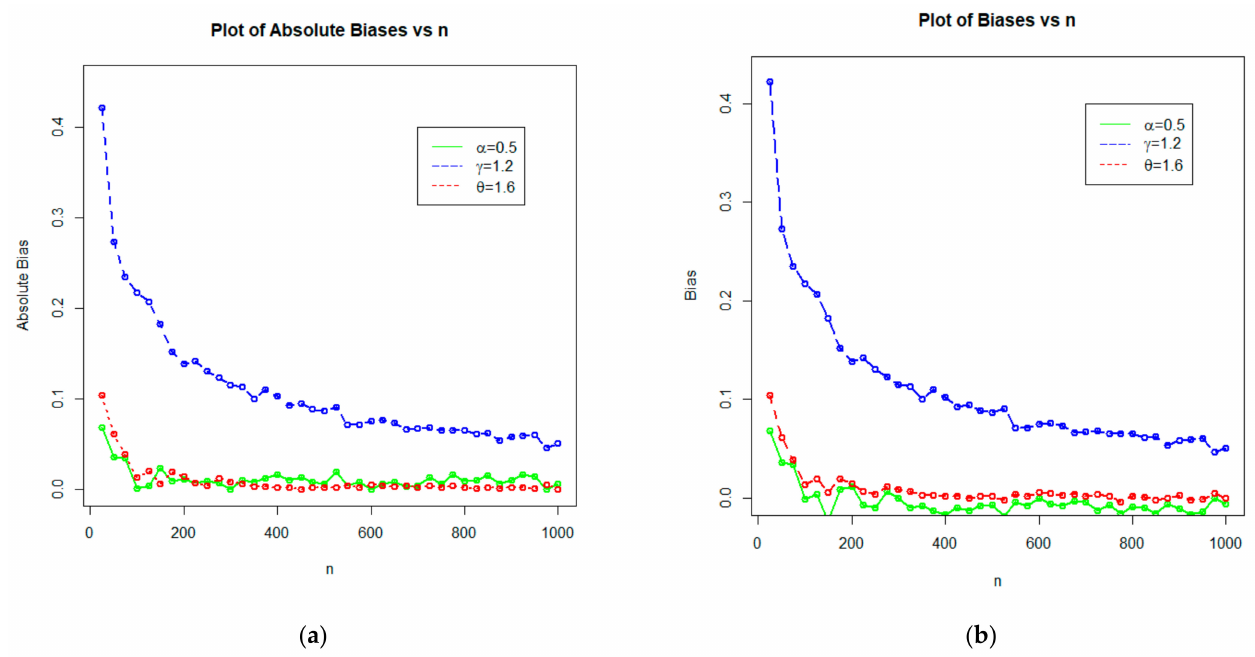
Figure 10. Plots of ( a ) absolute biases vs. n, and ( b ) bias vs. n for Set 3: α = 0.5, γ = 1.2, θ =